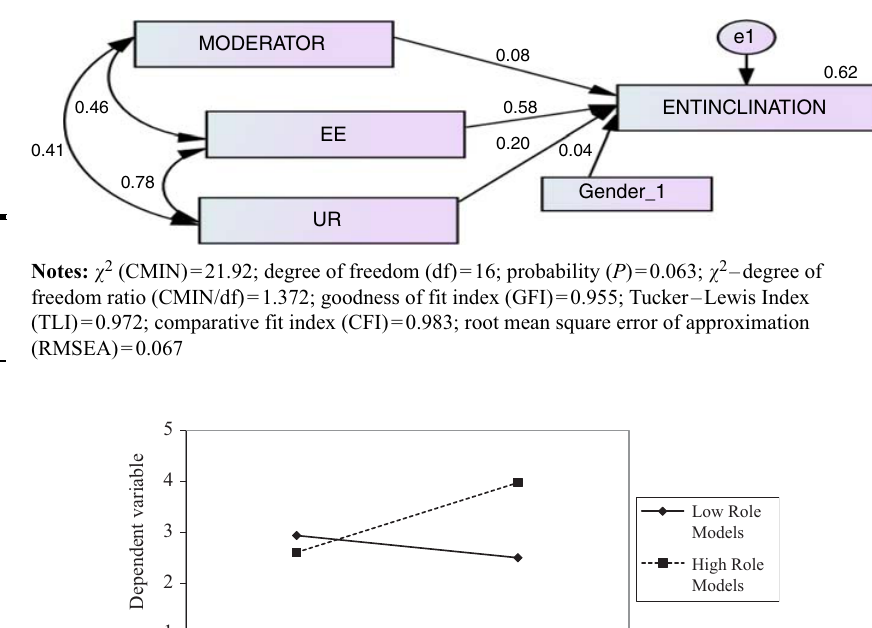
Figure 7. Interaction